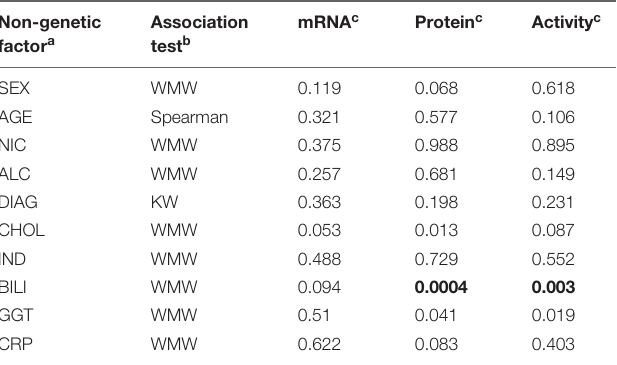
TABLE 2 | Influence of non-genetic factors on CYP2C8